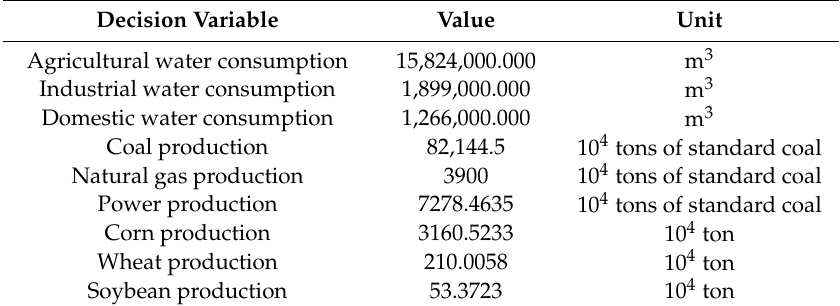
Figure 3. Comparison diagram of water consumption of different departments as well as different energy and food production in Inner Mongolia. Table 11. The planned value and optimal value of decision variable in 2020. Decision Variable